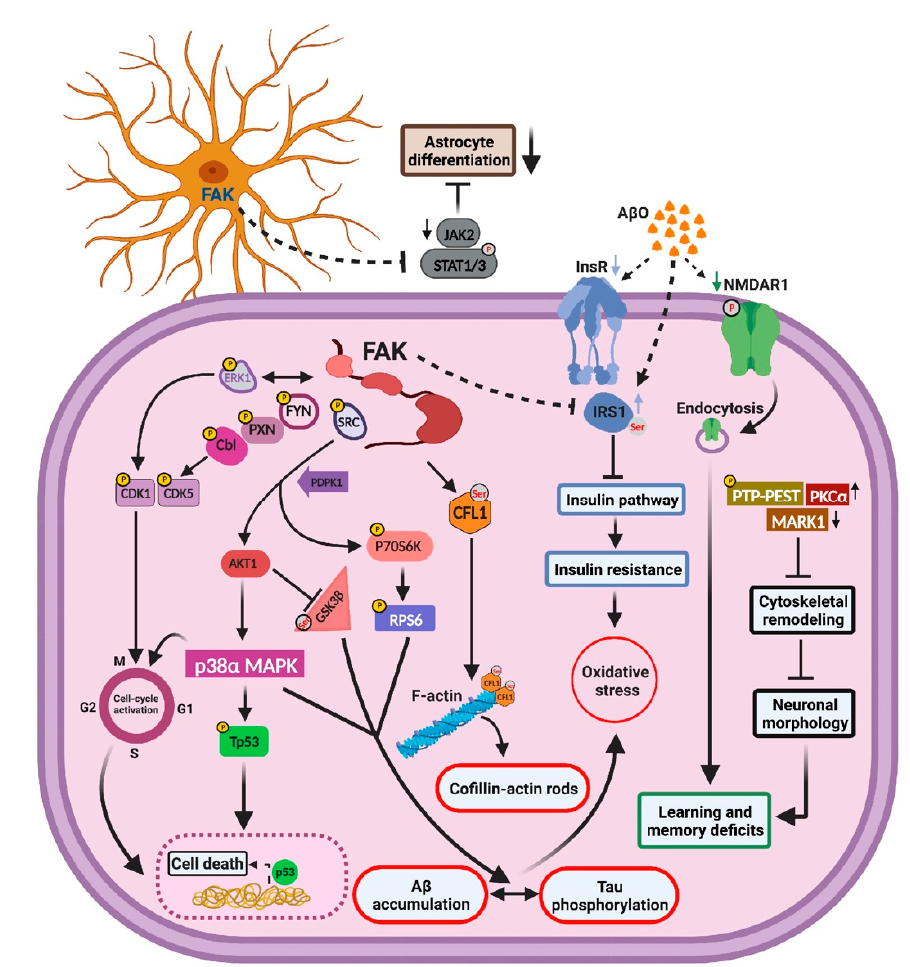
Figure 8. Schematic representation of the hippocampal molecular pathways controlled by FAK in the 3xTg-AD mouse model. FAK regulates hippocampal signaling pathways leading cytoskeletal remodeling that affects neuronal morphology. FAK blocks astrocyte differentiation via the JAK-STAT pathway and increases Tau hyperphosphorylation through PI3K/AKT and RPS6 signaling cascades. FAK activates cell cycle re-entry which leads to neuronal cell death by controlling CDKs and p38 α -MAPK, while downregulating the insulin signaling pathway, thereby increasing insulin resistance and leading to oxidative stress. “P” represents tyrosine phosphorylation of a protein; “Ser” represents serine phosphorylation. Arrows represent increase or decrease in expression or phosphorylation of specific proteins, as indicated by our antibody microarrays.